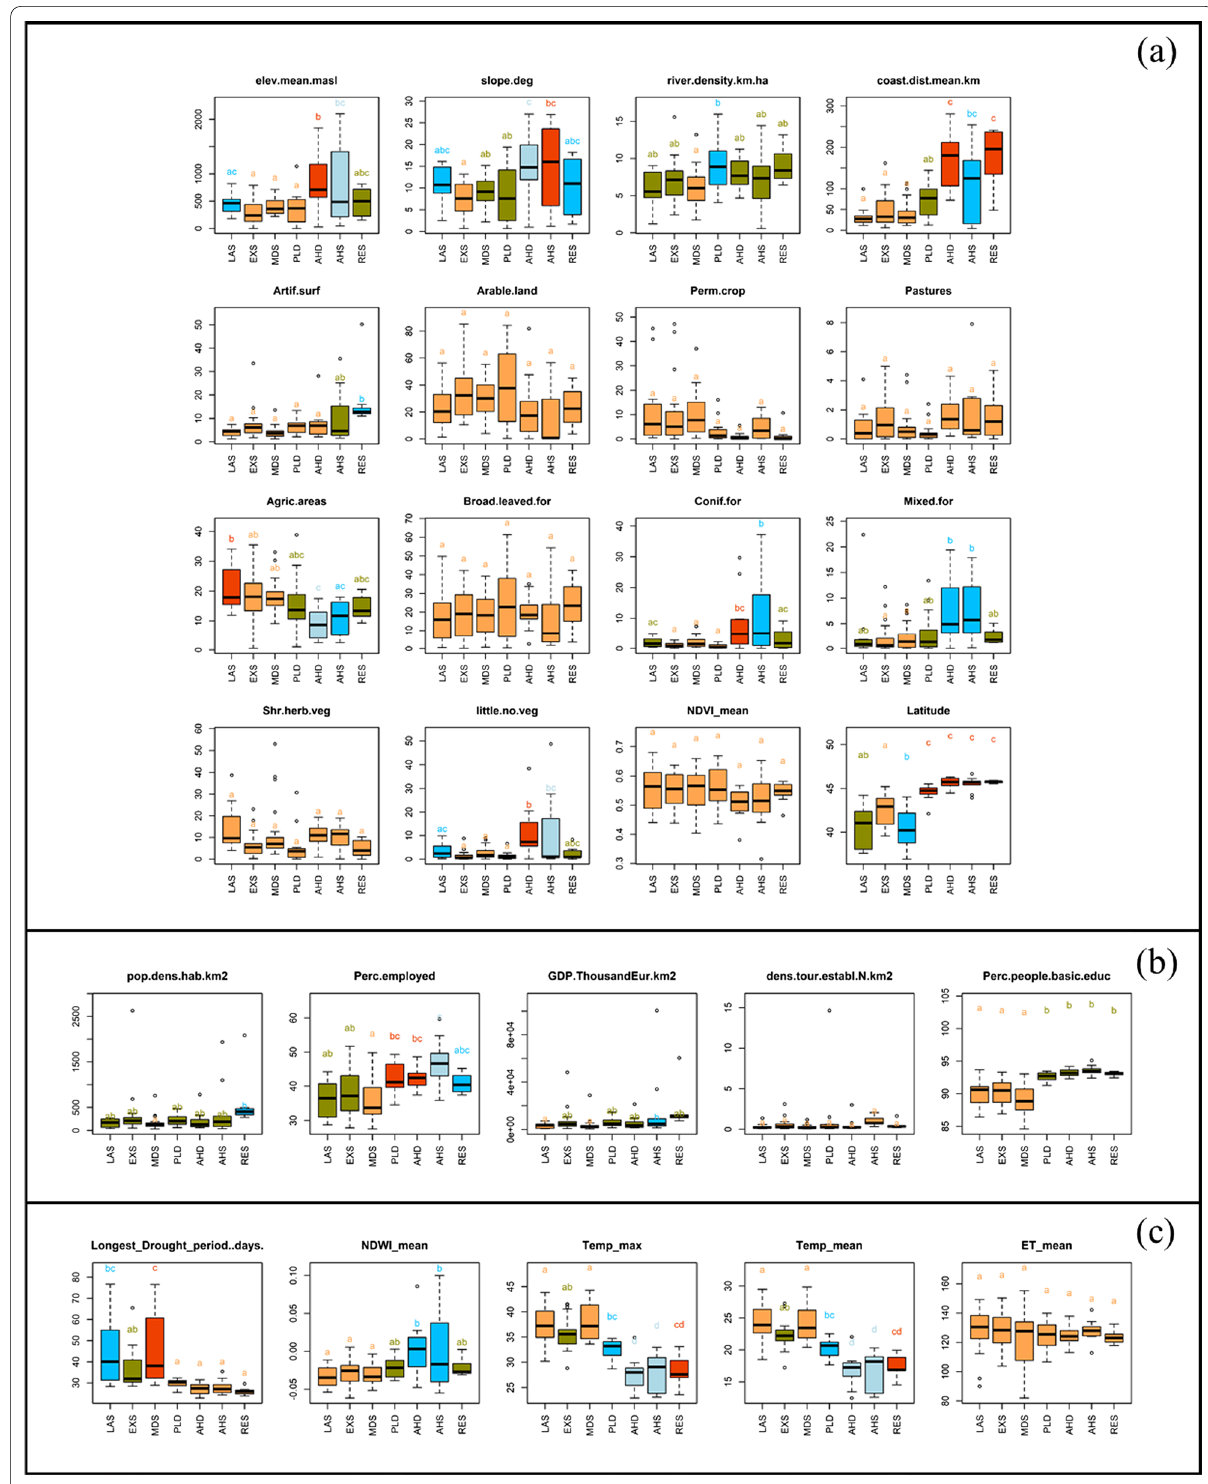
Fig. 4 Box plots showing the distribution of values for each biophysical ( a ), socioeconomic ( b ) and climatic ( c ) variable. For each plot, a pyroregion was assigned to a specific group represented by a letter above each box, in accordance to Post-hoc Tukey honestly significance difference. Clusters belonging to the same group were not significantly different ( P <